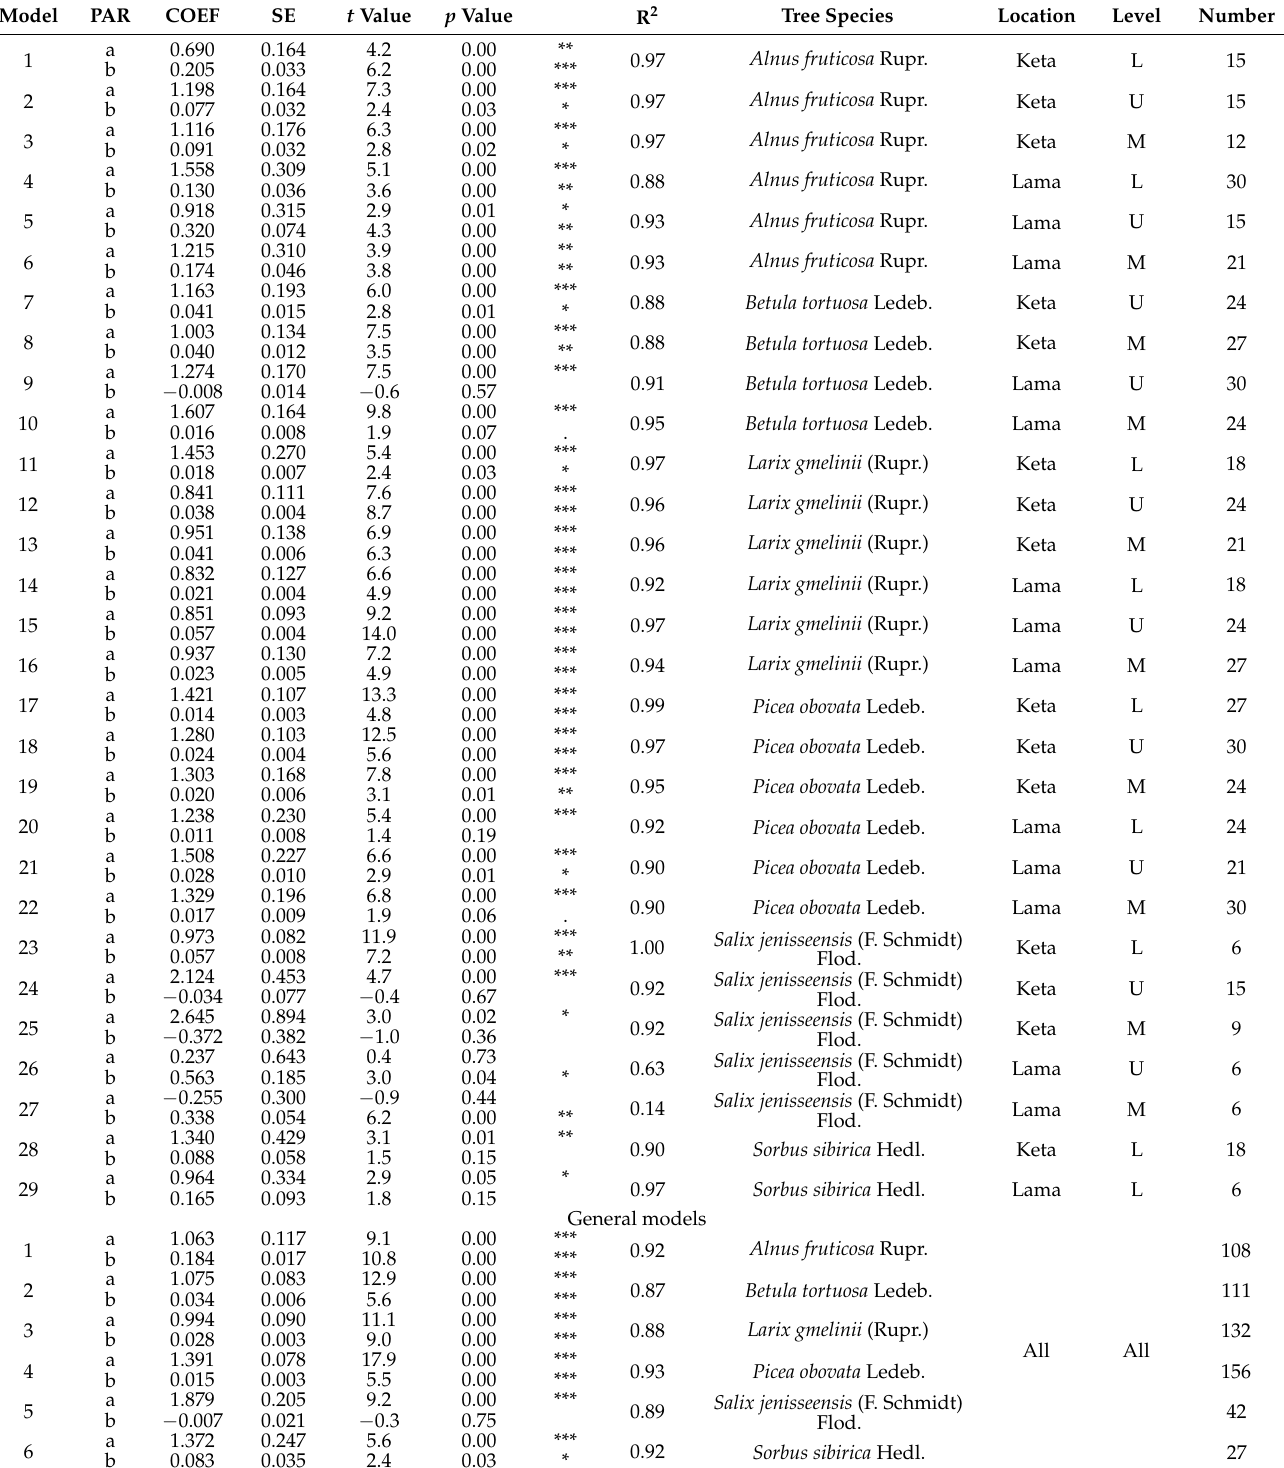
Table 1. Statistical parameters of derived height-diameter models (Model—identification number of the derived model, PAR—coefficient in Equation (1), COEF—value of the coefficient in Equation (1), SE—standard error, t value— t -value of Student test of a coefficient, p value—probability of t -value and its significance as follows: .—90%, *—95%,